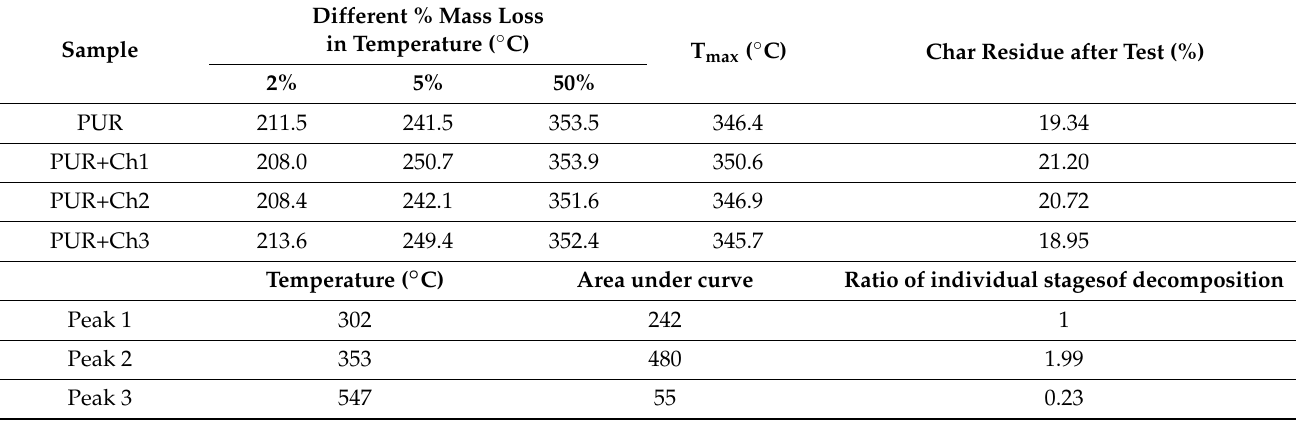
Table 5. Results of TGA